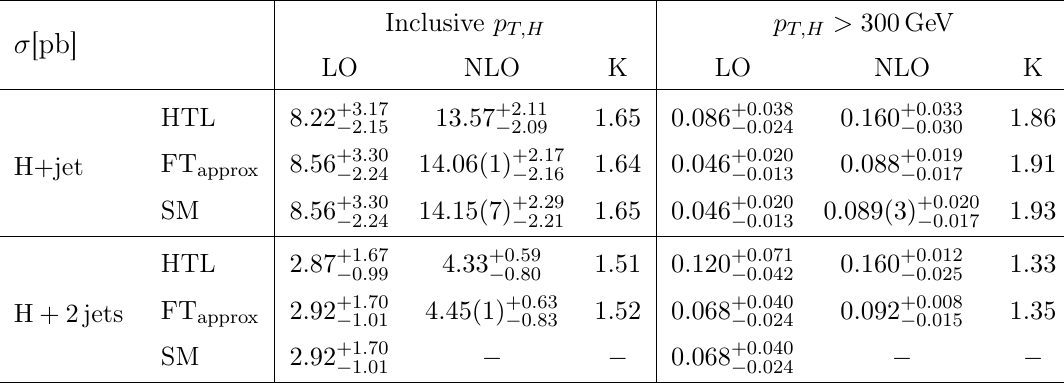
> 40 GeV ; p T ; j > 30 GeV . 1 2